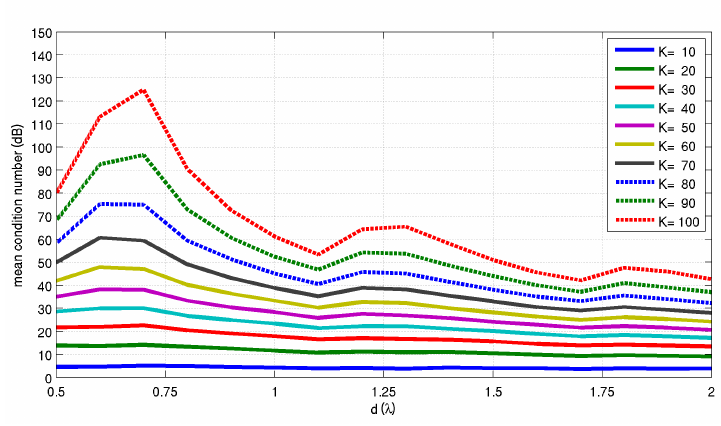
Figure 6. Mean condition number of the channel matrix as a function of the inter-element distance d and the number of users K